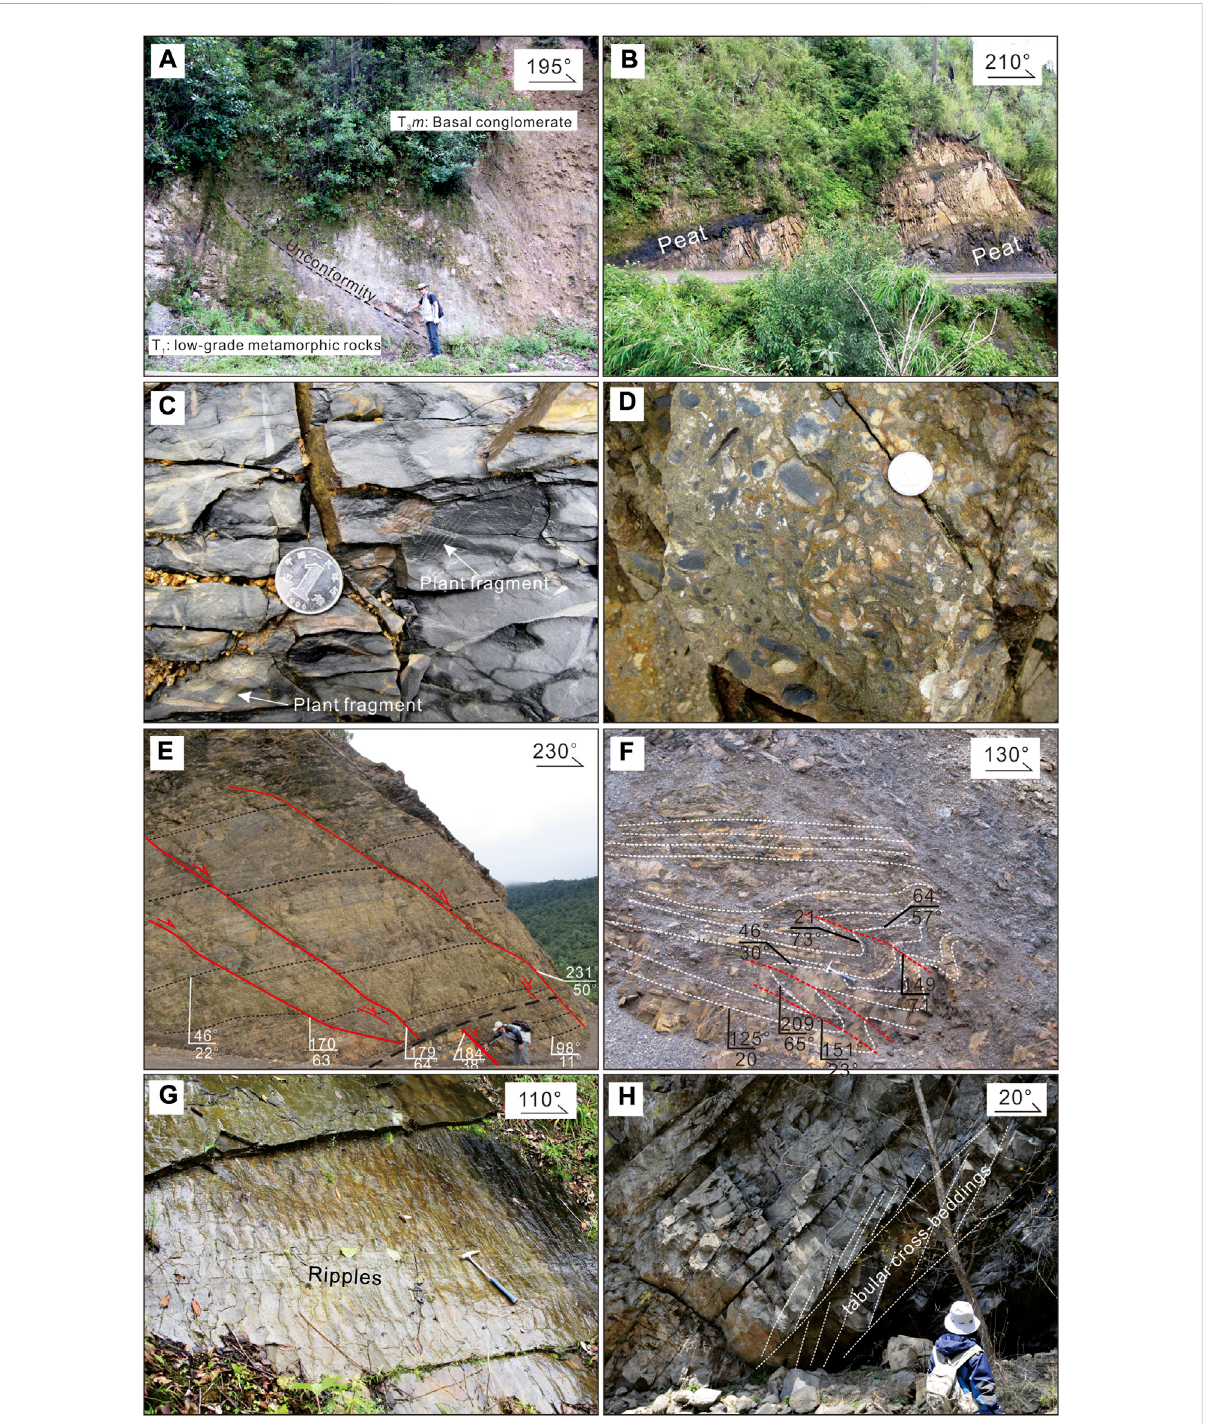
Fieldphotographs showingtypicalsedimentary featuresoftheMaichuqingFormation. (A) The MaichuqingFormation nonconformablyoverlies the early Triassic low-grade metamorphic rocks (GPS: 99.38 ′ 17 ″ , 26.16 ′ 33 ″ ); (B) Peats in the high level of the lower segment of the Maichuqing Formation; (C) Plantfragmentsinsiltstone; (D) Conglomerate; (E) and (F) Syn-sedimentationfaultsandfoldsinsiltstoneandmudstone; (G) Ripplesin siltstone; (H) Planar cross-beddings of